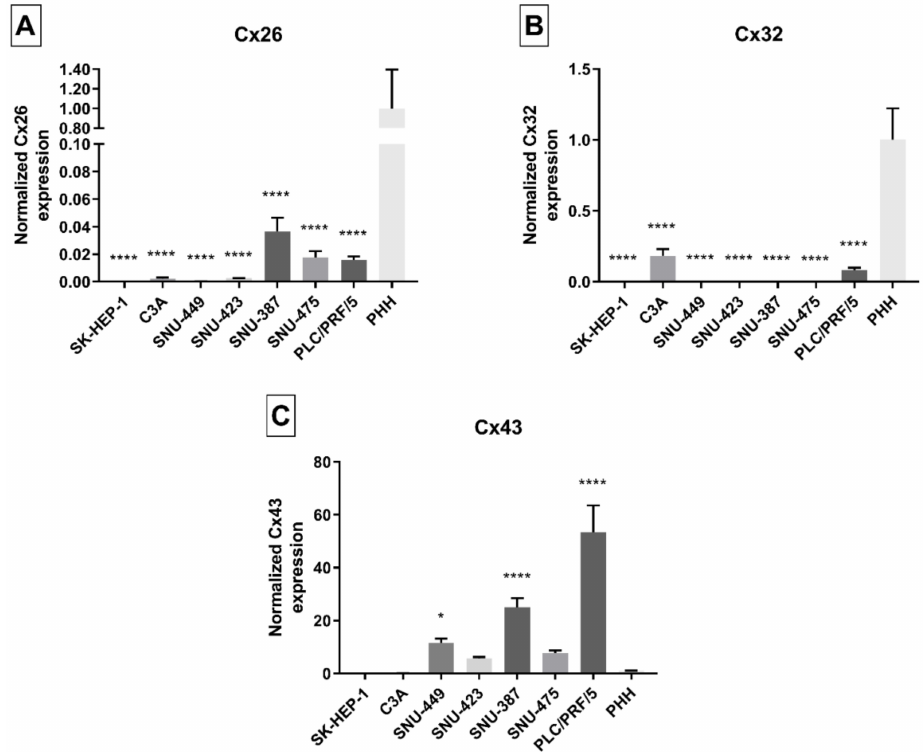
Figure 2. Cx26 ( A ), Cx32 ( B ) and Cx43 ( C ) gene expression in liver cancer cell lines and primary human hepatocytes (PHH). Cancer cell lines were grown to 100% confluence, while PHH were used in suspension when total RNA was extracted ( n = 1, N = 3). Subsequently, real-time quantitative reverse transcription polymerase chain reaction (RT-qPCR) analysis was performed. Relative alterations compared to PHH were calculated according to the Pfaffl method in qbase + (Biogazelle, Gent, Belgium). Data are expressed as mean ± standard deviation with * p ≤ 0.05 and **** p ≤ 0.0001 compared to the PHH